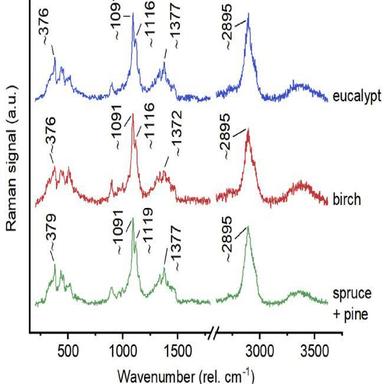
Baseline corrected and normalized Raman spectra of CPD treated pulp fibers.